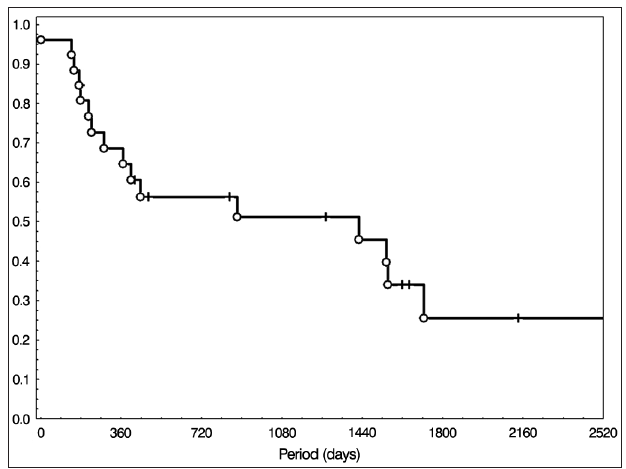
Figure 1. Disease-free survival in patients treated with surgery followed by radiotherapy.